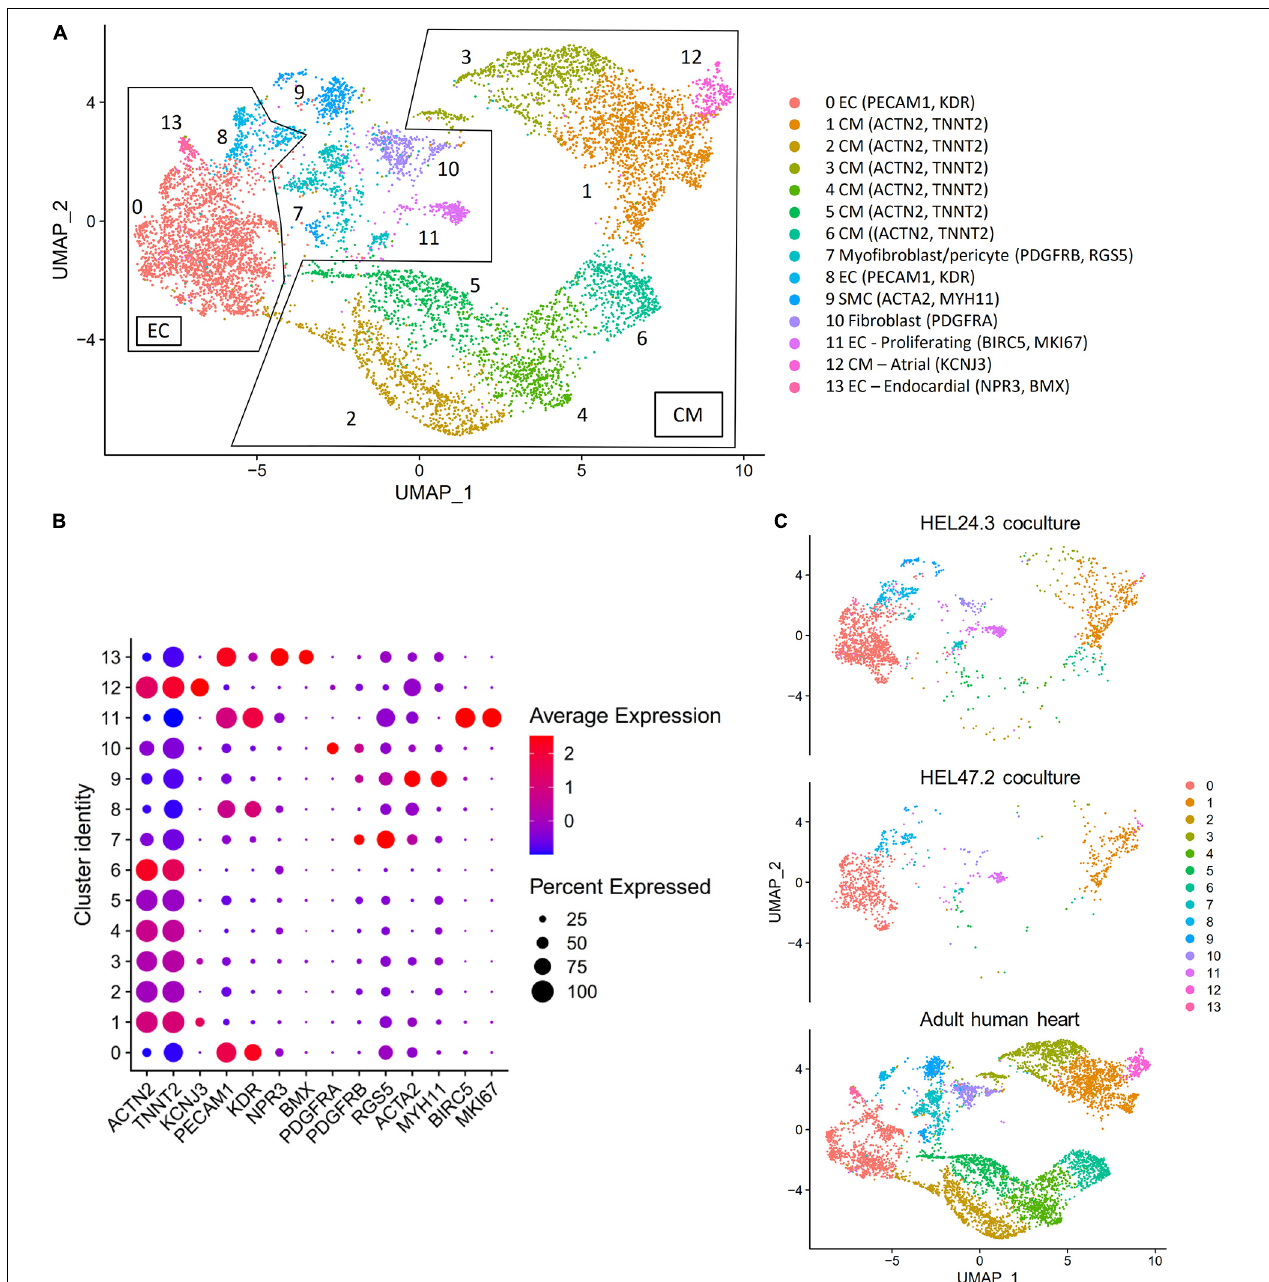
FIGURE 2 | Co-culture hiPS-CM/EC transcriptomics compared to the human heart, with single cell transcriptome data of three combined samples [HEL24.3 co-culture of hiPS-CMs and hiPS-ECs, HEL47.2 co-culture of hiPS-CMs and hiPS-ECs, and human heart derived cells from a previously published study (Wang et al., 2020)]. (A) UMAP (Uniform Manifold Approximation and Projection) plot of delineated clusters of the combined data. Endothelial cells (EC) and Cardiomyocytes (CM) have been highlighted. (B) Cardiomyocyte, endothelial cell, endocardial cell, fibroblast, pericyte, smooth muscle cell, and cell cycle marker expression in each cluster. (C) The combined UMAP separated according to the three